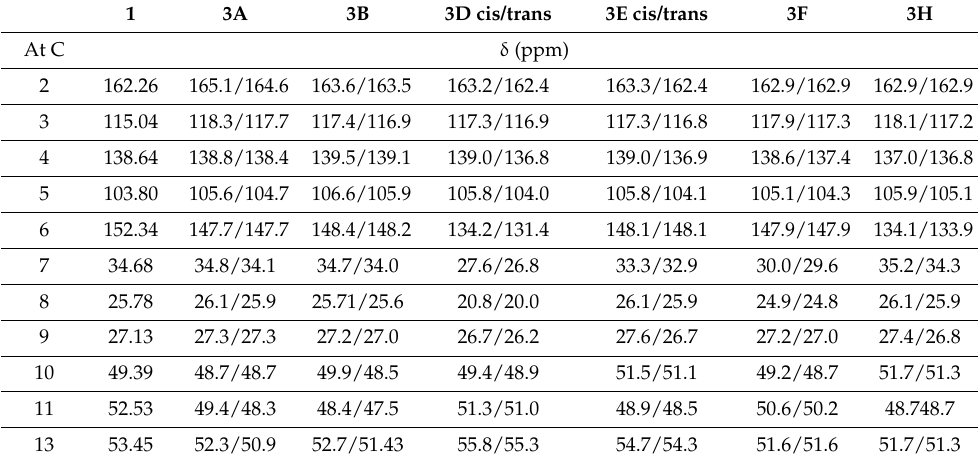
Table 2. Chemical shifts δ (ppm) of carbon atoms of cytisine ( 13 C NMR in CDCl 3 ).